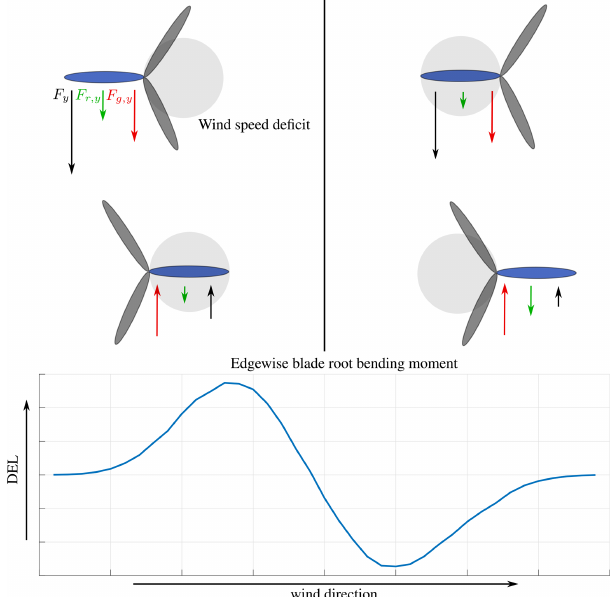
Figure A2. Schematic illustration of the edgewise blade root bending moment according to Reinwardt (2017). The aerodynamic force F r ,y , the gravitational force F g ,y , as well as the total force F y in the rotor plane at different wake situations are marked.